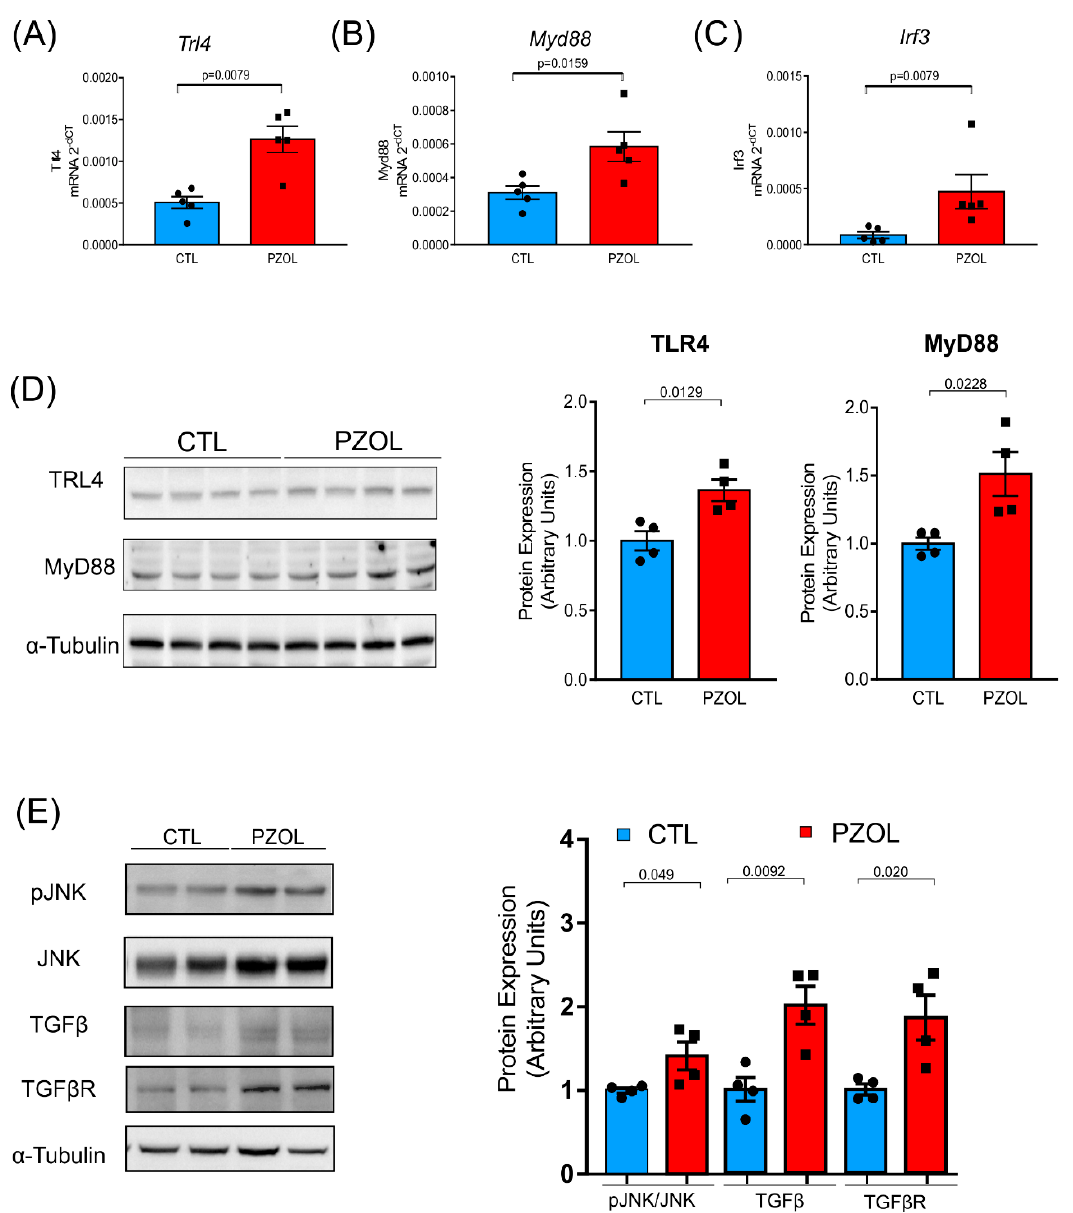
Figure 9. Inflammatory and TGF β signaling in liver of pantoprazole-treated mice. mRNA levels of ( A ) TLR4 ; ( B ) MyD88 ; ( C ) IRF3 ( n = 5 animals per group); ( D ) representative Western blots of TLR4 and MyD88; and quantification of the Western blots ( n = 4 animals per group); ( E ) representative Western blots of phosphorylated JNK and total TGF β , TGF β receptor and of α -tubulin of CTL and PZOL-treated mice and quantification of the Western blots ( n = 4 animals per group). Mean ± standard deviation and t -test statistical comparisons.